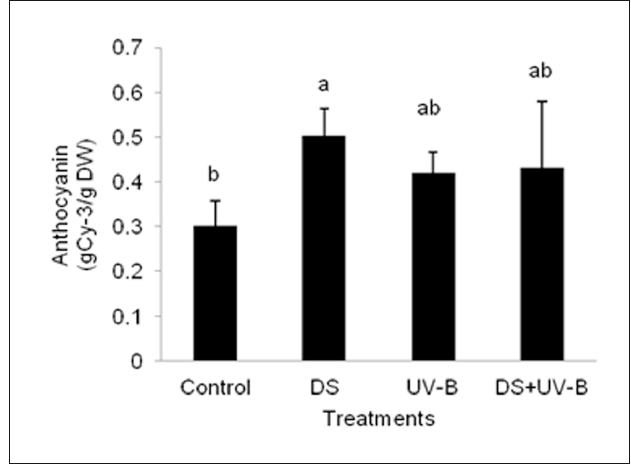
Fig. 7: Total anthocyanin content (mg Cy g -1 DM) of lettuce at harvest in response to drought stress, UV-B radiation and in combination of drought stress and UV-B radiation. Vertical bars represent standard deviation, and different letters indicate differences at the significance level p ≤ 0.05 (Tukey test). (Control = well-watered; DS = drought stress, i.e. water-deficit; UV-B = well-watered with UV-B radiation of 0.11 kJ m -2 ; DS+UV-B = drought stress i.e. water-deficit in combination with